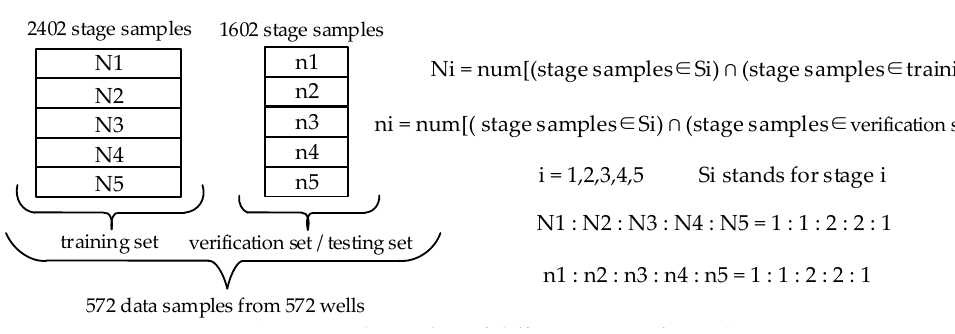
Figure 5. Relationship of different types of samples.